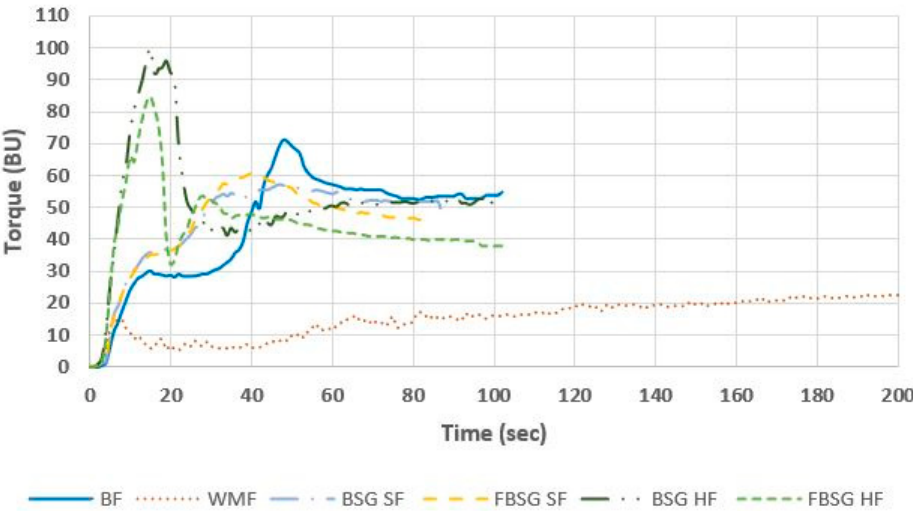
Figure 1. Graphical representation of results from GlutoPeak analysis using baker’s flour (BF), wholemeal flour (WMF), brewers’ spent grain (BSG) and fermented brewers’ spent grain (FBSG). SF and HF denotes “source of fibre addition level” and “high in fibre addition level”, respectively.